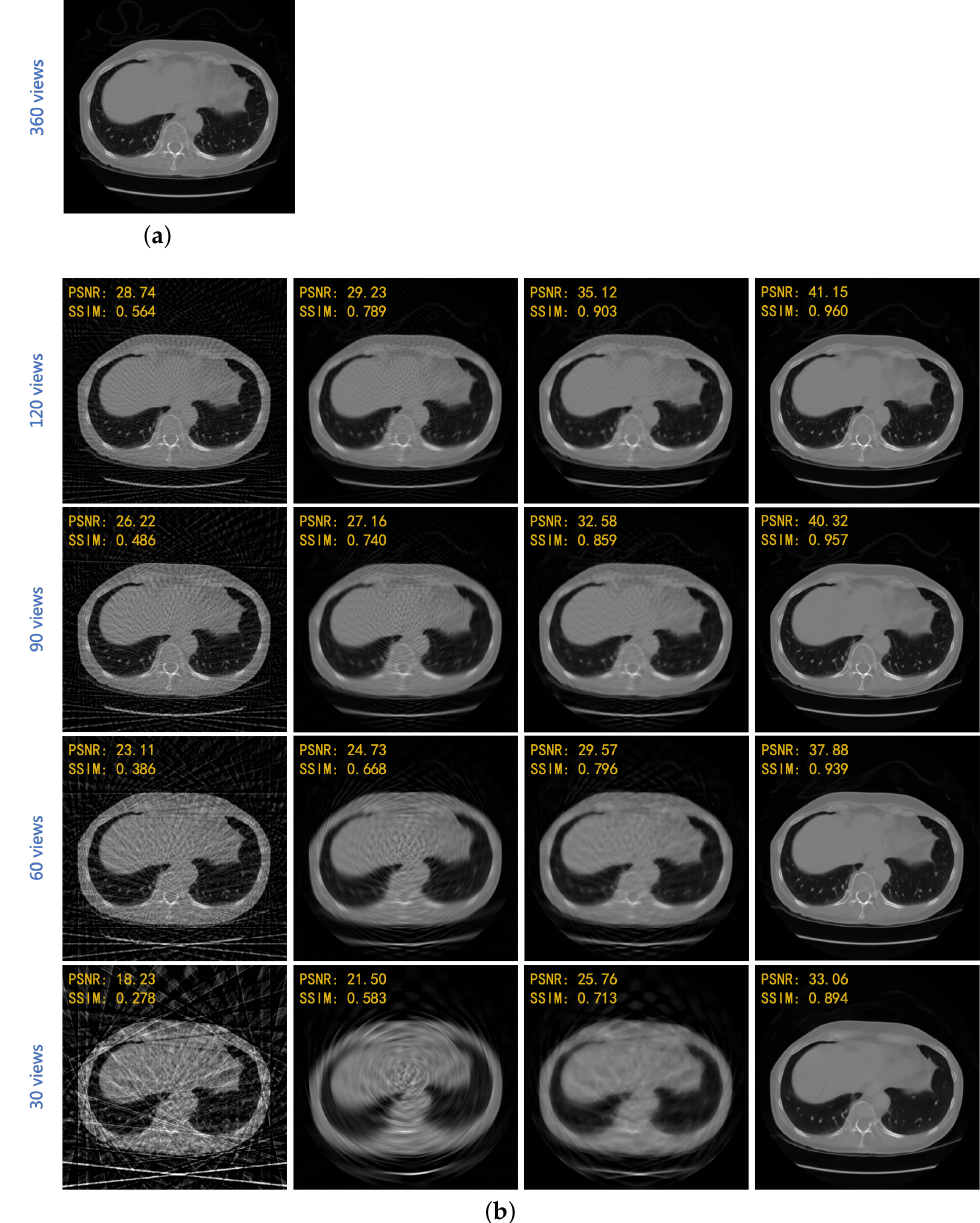
Figure 5. Reconstruction results of classical algorithms and the proposed one at different angular intervals. ( a ) Ground truth; ( b ) reconstruction results under four sparse coefficients. The first column is FBP, and the second one is FBP with a linearly interpolated sinogram. The third column is a TV-based SART algorithm, and the last one is the proposed